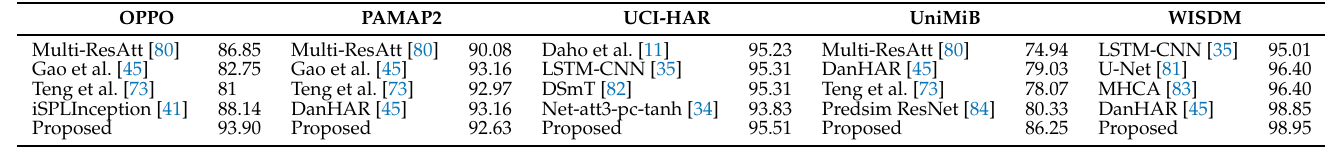
Table 13. Results of related models’ accuracies ( % ) for common